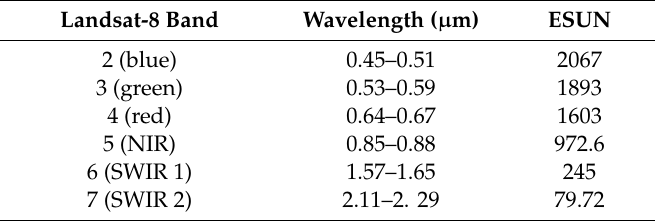
Table 2. Landsat-8 extra-terrestrial solar irradiation (ESUN) (extra-terrestrial solar irradiation)